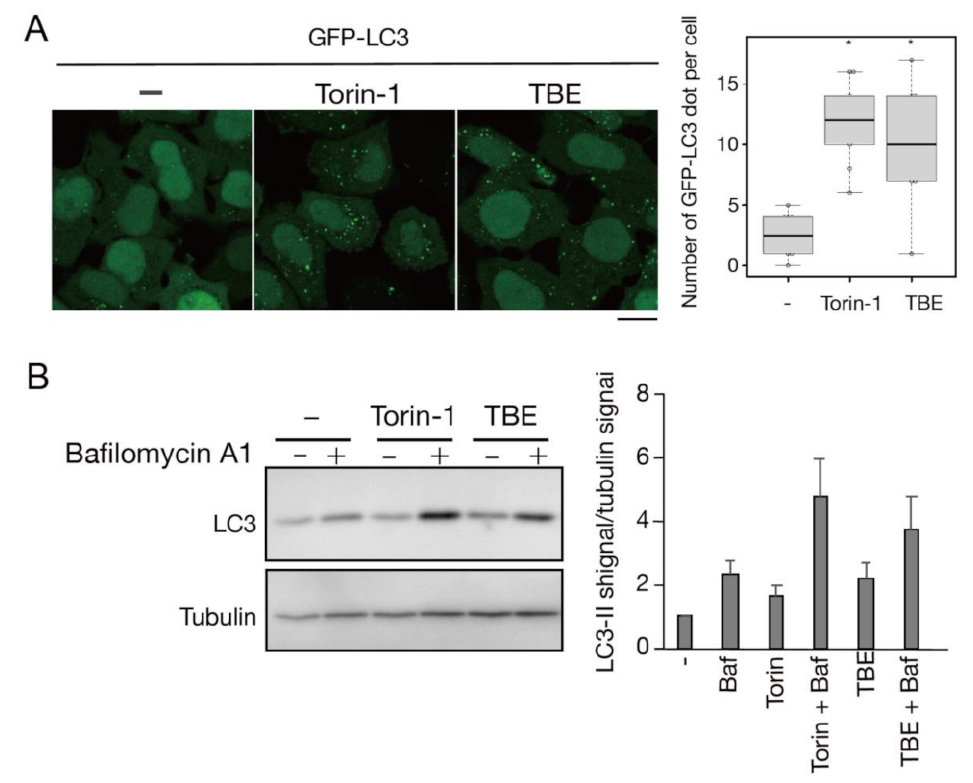
Figure 2. TBE induces autophagy flux under nutrient-rich conditions. ( A ) GFP-LC3-expressing HeLa cells were treated with Torin-1 or TBE for 6 h under nutrient-rich conditions. The number of GFP punctae per cell was counted, with over 20 cells in each sample. Median: line; upper and lower quartiles: boxes; 1.5 interquartile range: whiskers. Bar: 10 µ m ( B ) HeLa cells were treated with Torin-1 or TBE with or without bafilomycin A1 for 6 h. The lysates were assessed by Western blotting with anti-LC3 antibody. The graph shows the average and standard deviation of the ratio of the LC3 signal to the tubulin signal from three independent experiments. * denotes p < 0.05 by unpaired two-tailed Student’s t